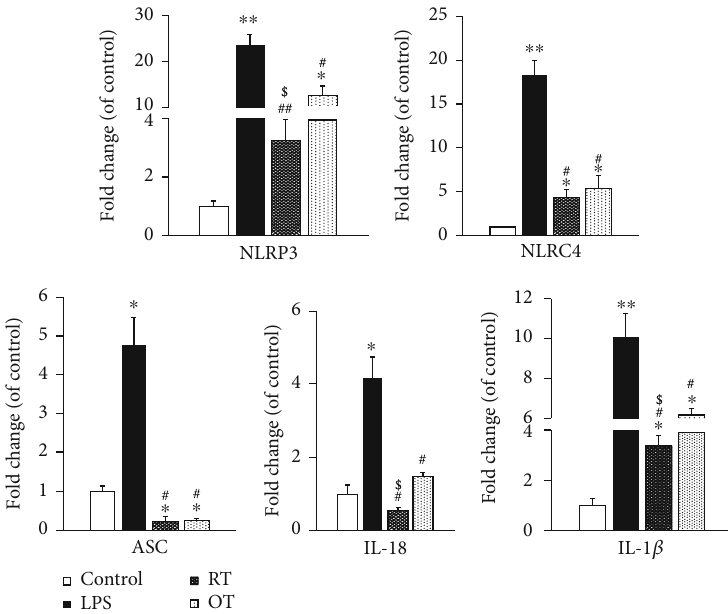
Figure 3: E ff ect of AEA on the expression of in fl ammasome-related genes in LPS-stimulated AGS cells. qRT-PCR of in fl ammasome component genes on AEA-treated cells after or before LPS-induced in fl ammation. Data are normalized by changes in B2M and are expressed as means ± SEM of three independent experiments. ∗ Indicates signi fi cantly fold changes compared to group, ∗ p < 0 : 05 , and ∗∗ p < 0 : 01 ; # compared to LPS group, # p < 0 : 05 , and ## p < 0 : 01 ; $ compared to OT group and $ p < 0 : 05 .